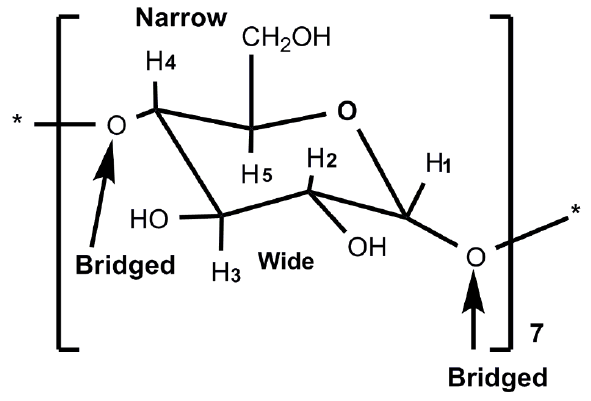
Figure 7: Structure of β-CD and its oligosaccharide